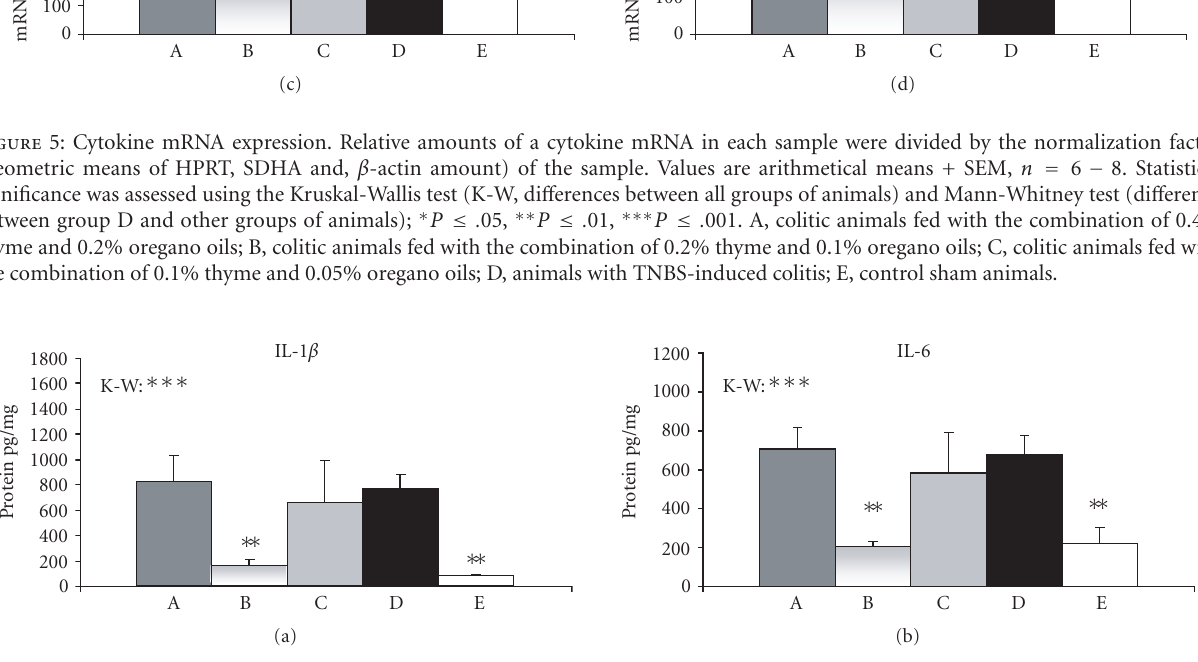
Figure 6: IL-1 β and IL-6 protein expression. Values are arithmetical means + SEM, n = 6 − 8. Statistical significance was assessed using the Kruskal-Wallis test (K-W, di ff erences between all groups of animals) and Mann-Whitney test (di ff erence between group D and other groups of animals); ∗∗ P ≤ . 01, ∗∗∗ P ≤ . 001. A, colitic animals fed with the combination of 0.4% thyme and 0.2% oregano oils; B, colitic animals fed with the combination of 0.2% thyme and 0.1% oregano oils; C, colitic animals fed with the combination of 0.1% thyme and 0.05% oregano oils; D, animals with TNBS-induced colitis; E, control sham